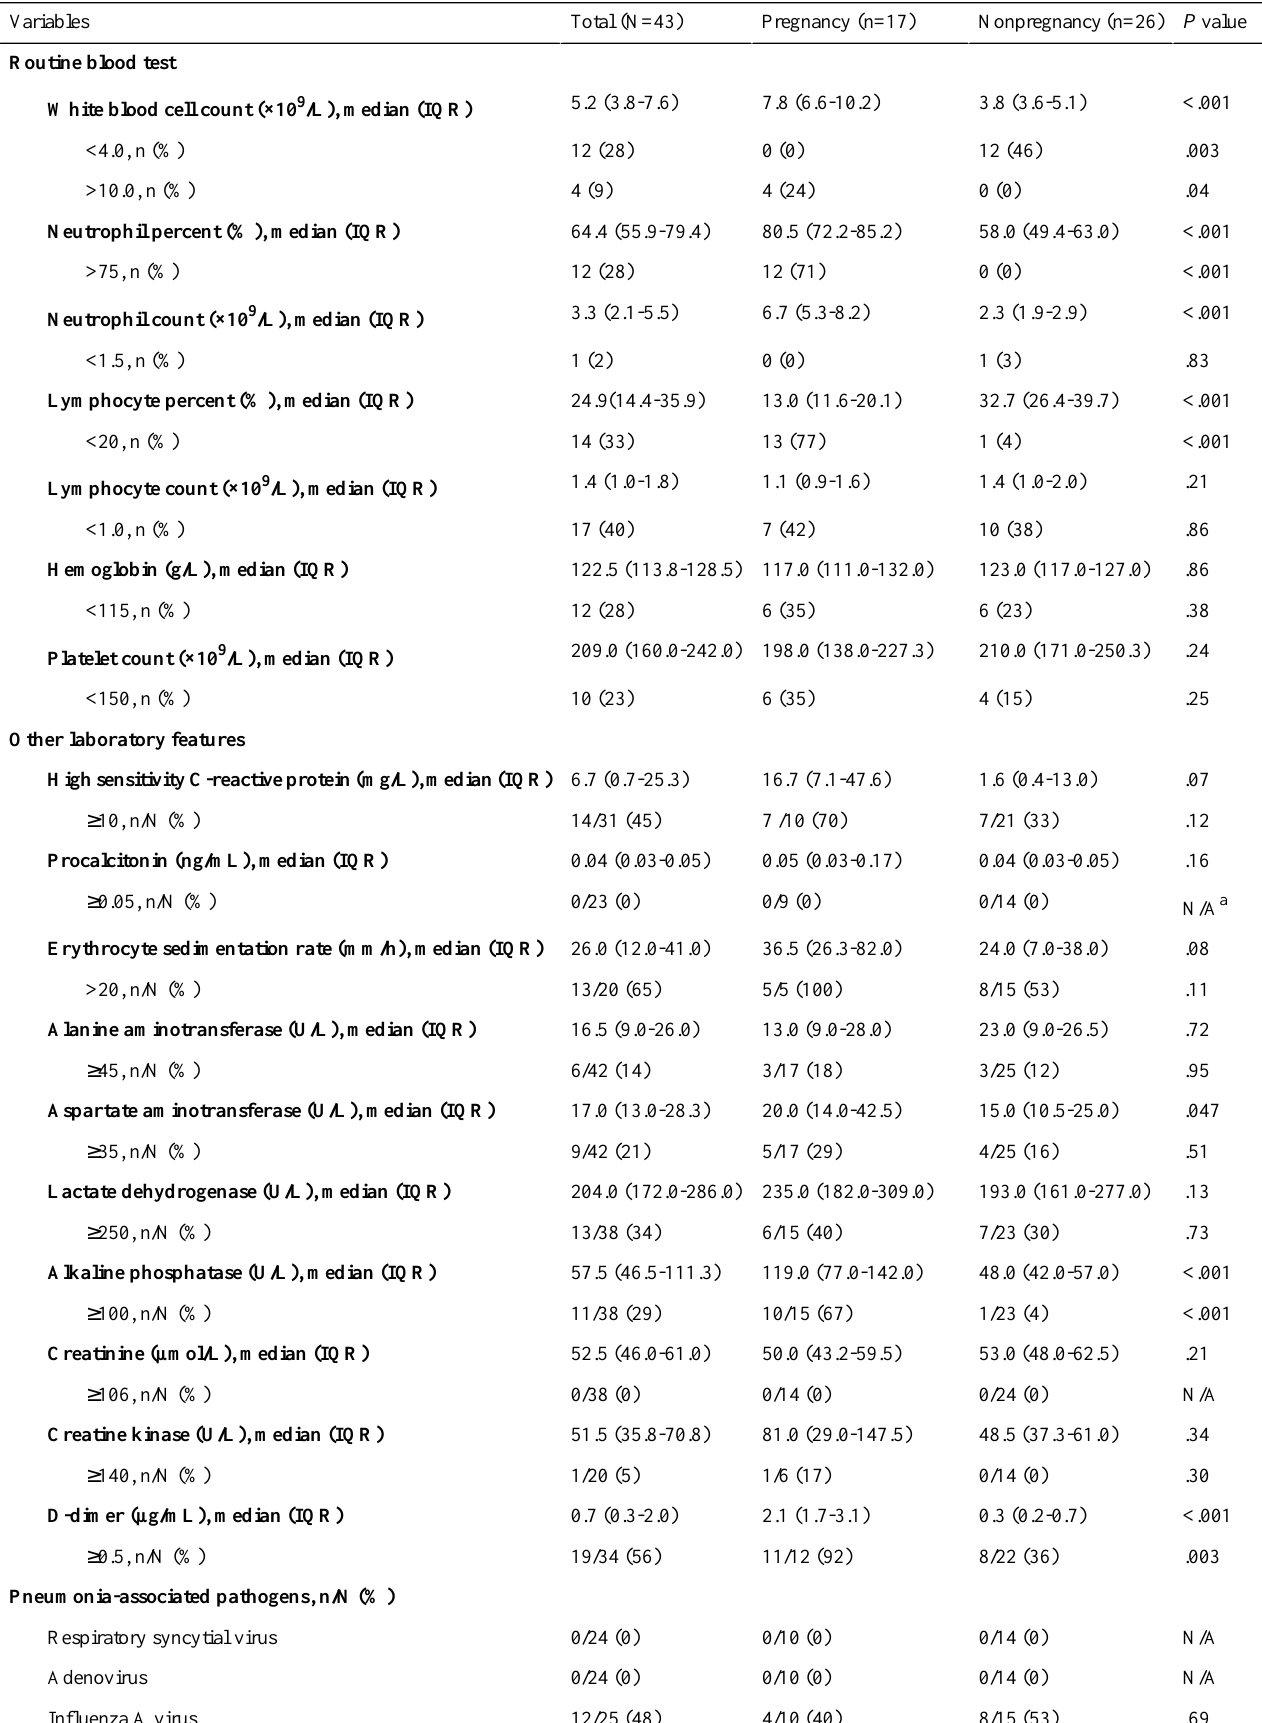
Table 2. Laboratory and imaging features of pregnant and nonpregnant women with the coronavirus